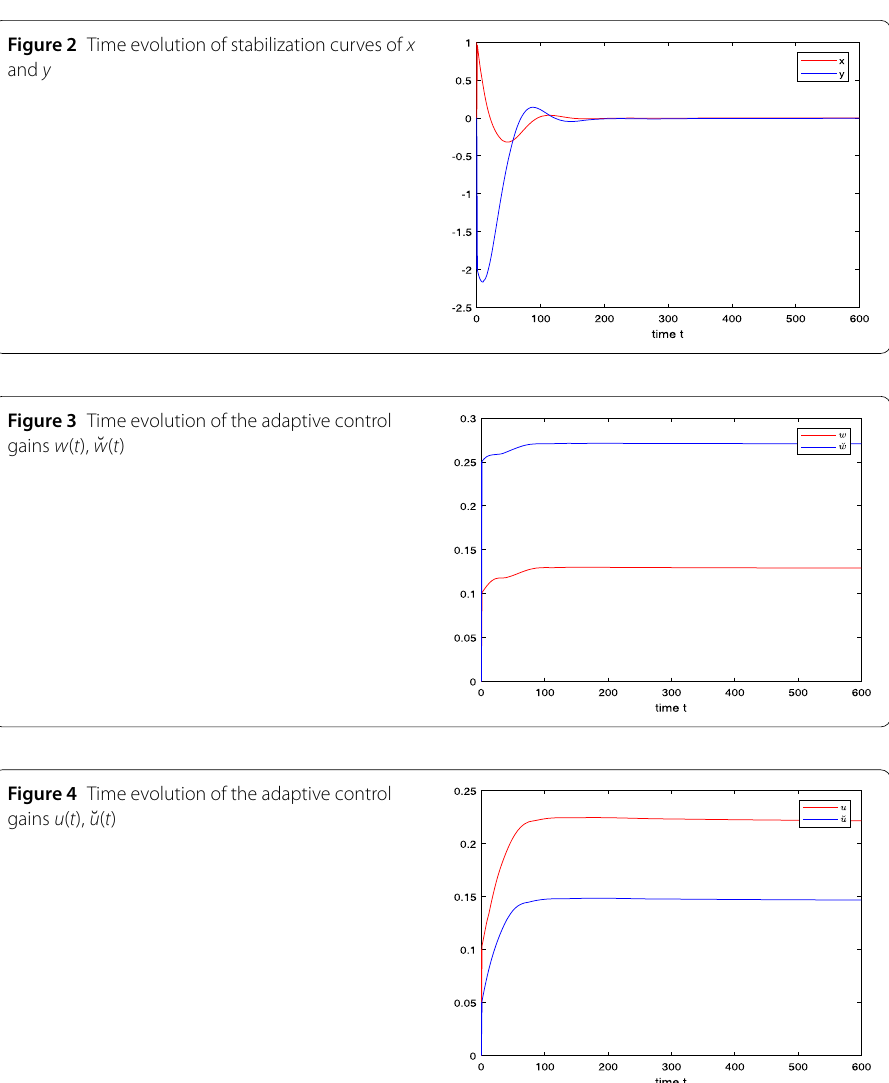
Figure 4 Time evolution of the adaptive control gains u ( t ), ˘ u ( t